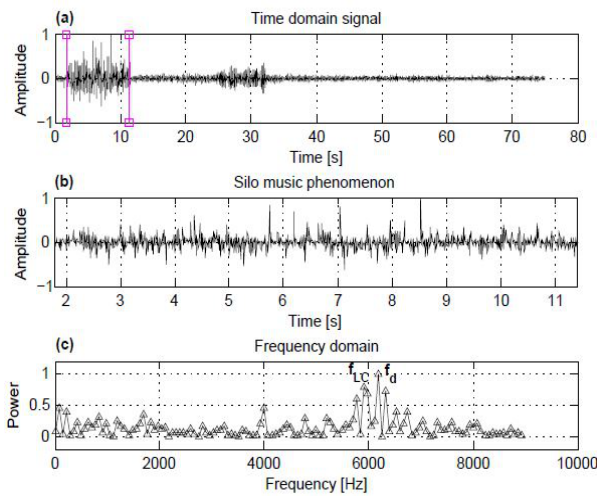
Figure 7. Signal of the SMP in time domain and frequency domain.